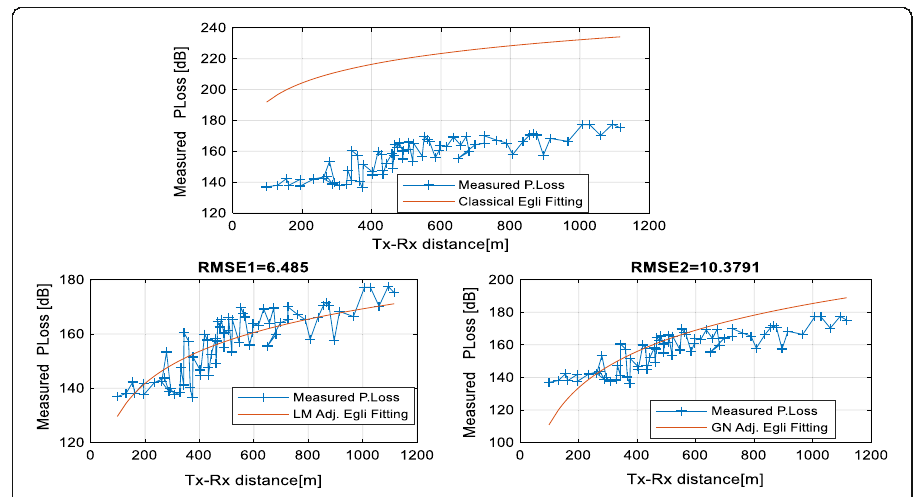
Fig. 4 Measured propagation loss estimation and their error distribution statistics using classical Egli model and adapted Egli model for Cell_1